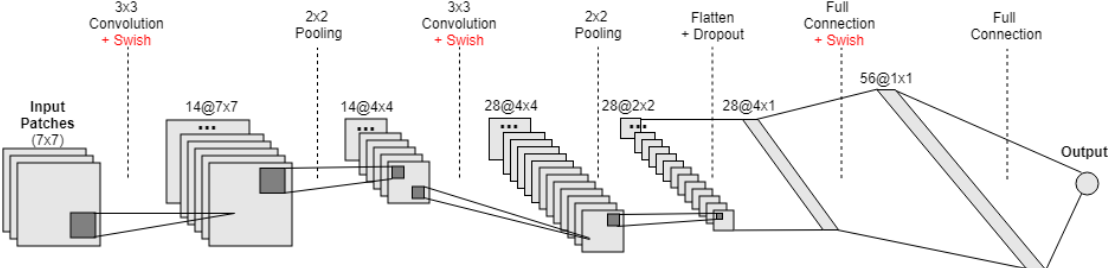
Figure 2. The considered convolutional neural network